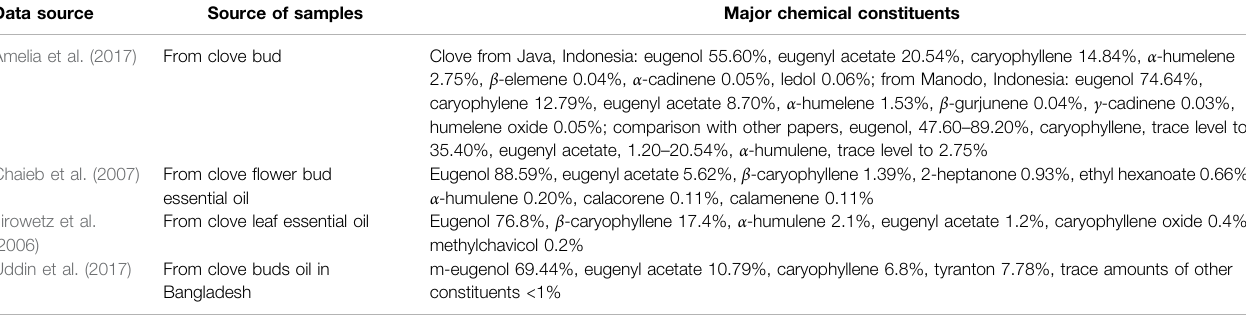
TABLE 1 | Major chemical constituents of clove plants and essential